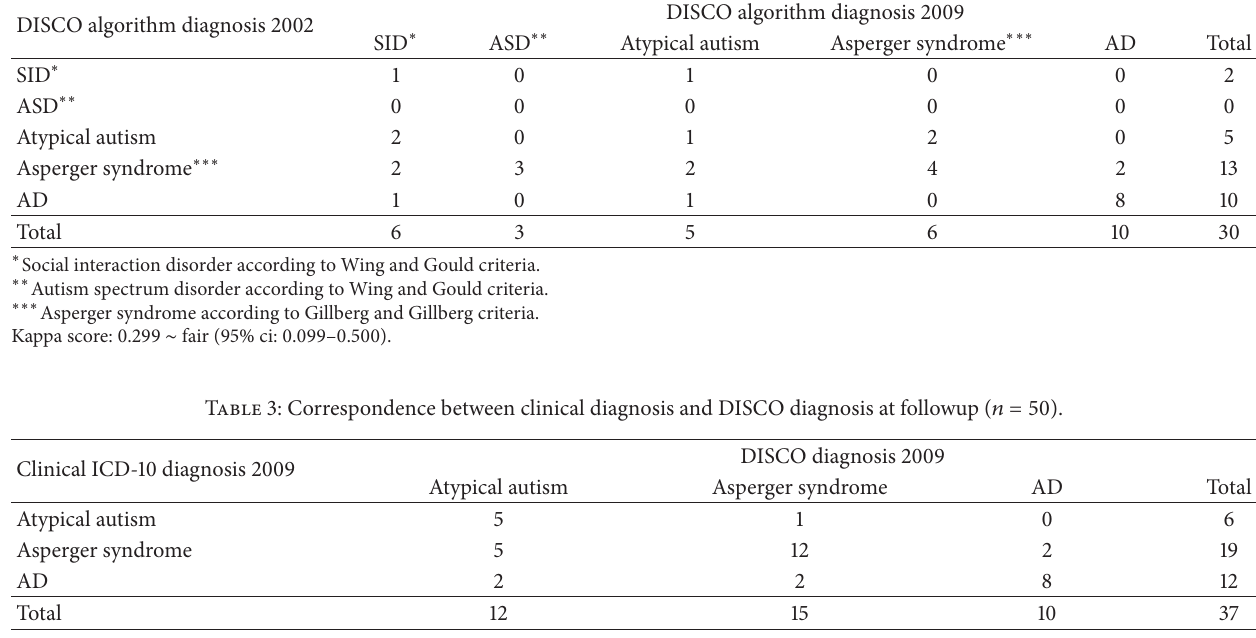
Table 2: Stability of DISCO algorithm diagnosis from 2002 to 2009 ( 𝑛 = 30 ). DISCO algorithm diagnosis 2002